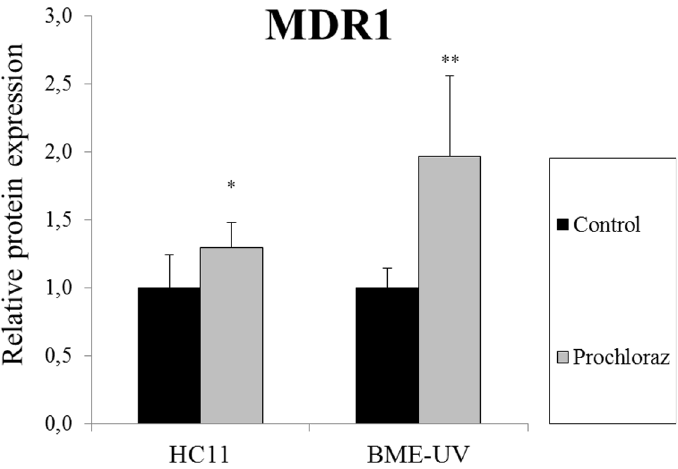
Fig 7. Relative expression of MDR1 following 30 μ M prochloraz treatment for 24 h in HC11 and BME-UV cells. The data is presented as means ± SD; n = 4 – 10. Statistically significant differences as compared to vehicle controls * p (cid:1) 0.05; ** p (cid:1) 0.01.